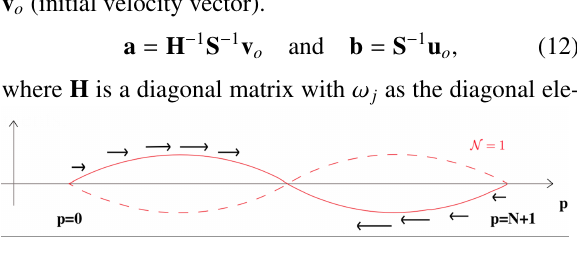
Figure 1. Sinusoidal waveform initial condition for a fixed-end and periodic granular